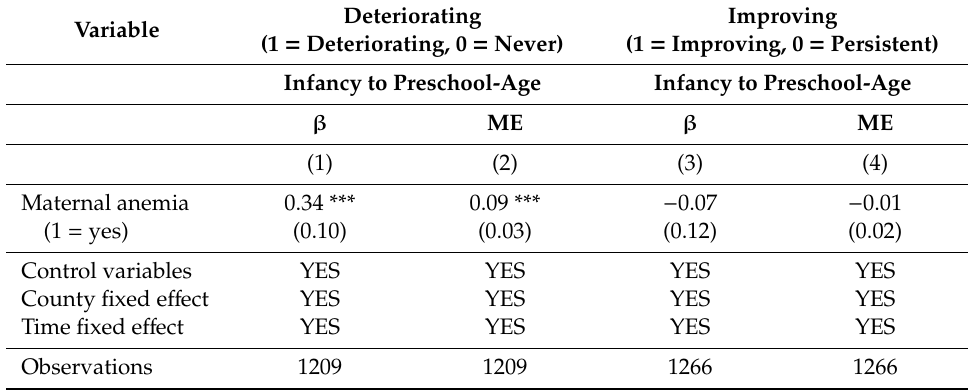
Table A3. Multivariate analysis of the association between maternal anemia status and evolutionary paths.